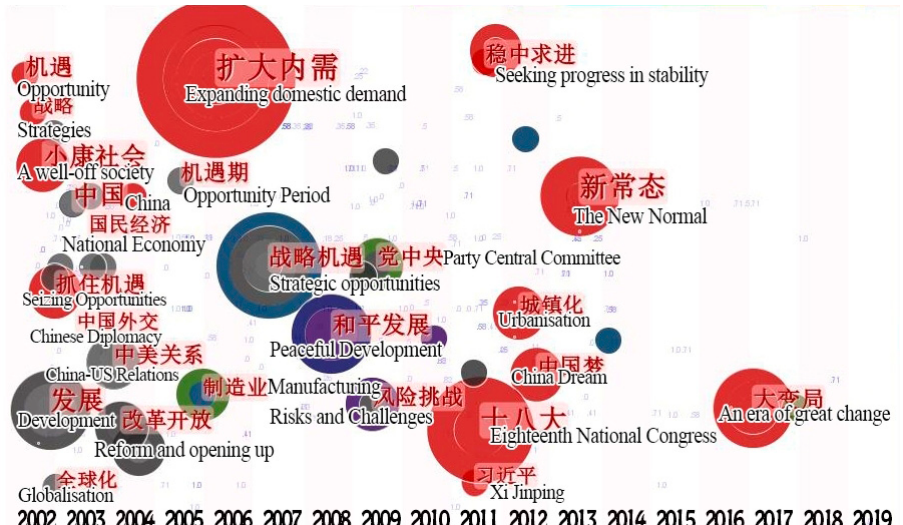
Figure 3. Keyword co-occurrence in the narrative of the ‘strategic opportunity period’ in Chinese academia.